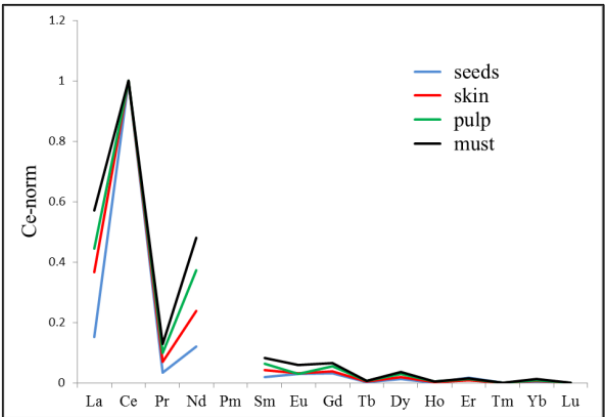
Figure 6. The diagram represents the lanthanide distribution in the various parts of Primitivo grapes. Figure is reprinted with permission from Ref. [7]. Promethium (Pm) is not measured as all of its isotopes are radioactive.